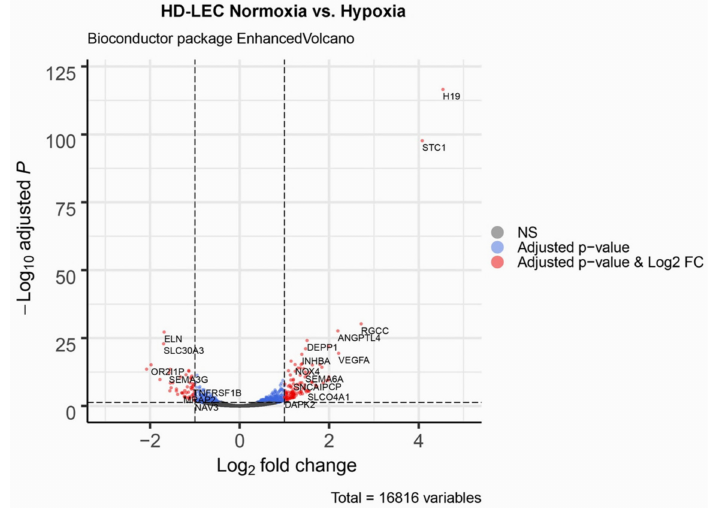
Figure 4. Volcano plot of significant genes. The dashed horizontal line signals statistical significance threshold (adjusted p -values ≤ 0.05). Two vertical lines show the threshold of log2 fold-change ≥ 1 and ≤− 1. The colors indicate for the genes whether they have adjusted p -values ≤ 0.05 (blue), or they are significantly regulated and have a log2 fold-change ≥ 1 or ≤− 1 (red). Produced with EnhancedVolcano v1.2.0. (www.bioconductor.org/packages/release/bioc/html/EnhancedVolcano.html).